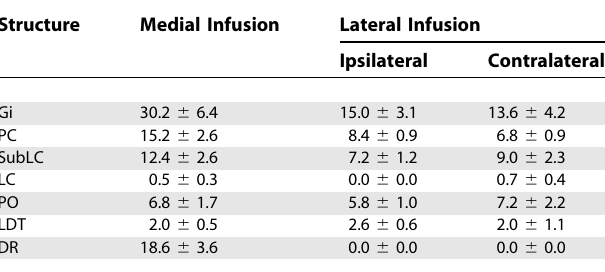
Table 1. Mean Number ( 6 Standard Error) of DiI-Labeled Neurons within Seven Medullary and Mesopontine Structures in P8 Rats